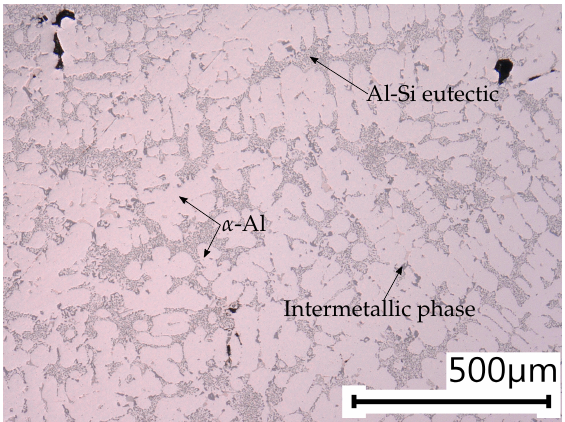
Figure 2. Representative metallographical specimen of position A with α -Al, Al-Si eutectic and intermetallic phases.